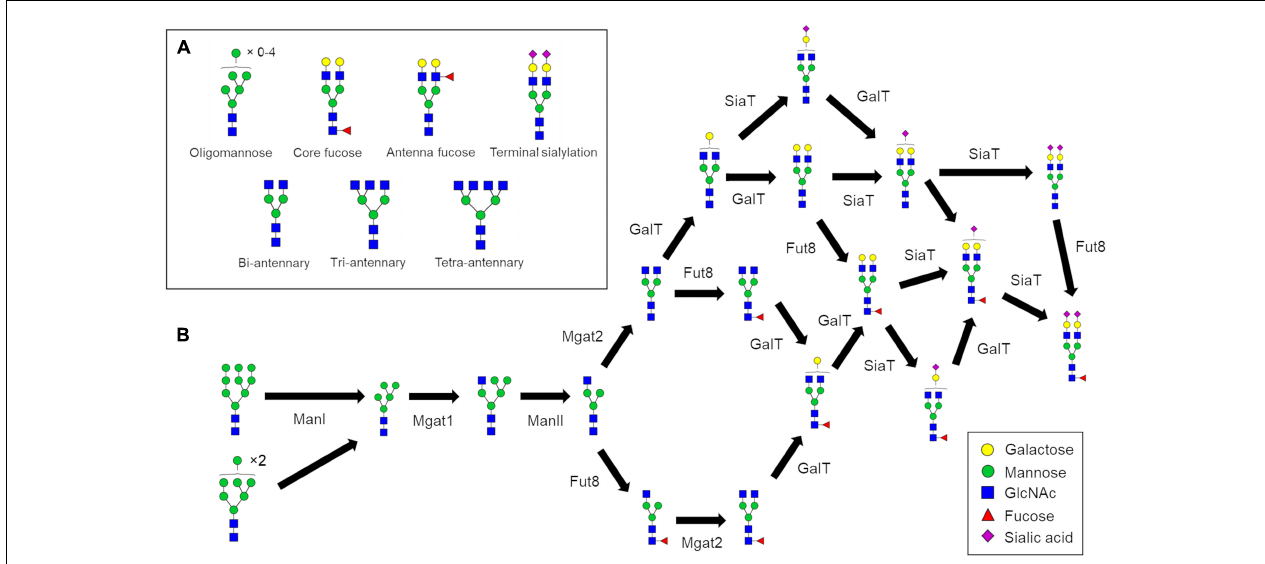
FIGURE 1 | N -glycan processing pathways to generate a fully sialylated bi-antennary glycan. (A) Pictorial examples of structural features of complex N -glycans that are referred to in this work. (B) N -glycan biosynthesis pathway for Fuc 1 GlcNAc 4 Man 3 Gal 2 NeuAc 2 starting with the two oligomannose glycans that enter the Golgi apparatus. The biosynthesis of complex N- glycans is characterized by increasing numbers of reaction paths that ultimately converge on structural nodes often due to the addition of terminating sialic